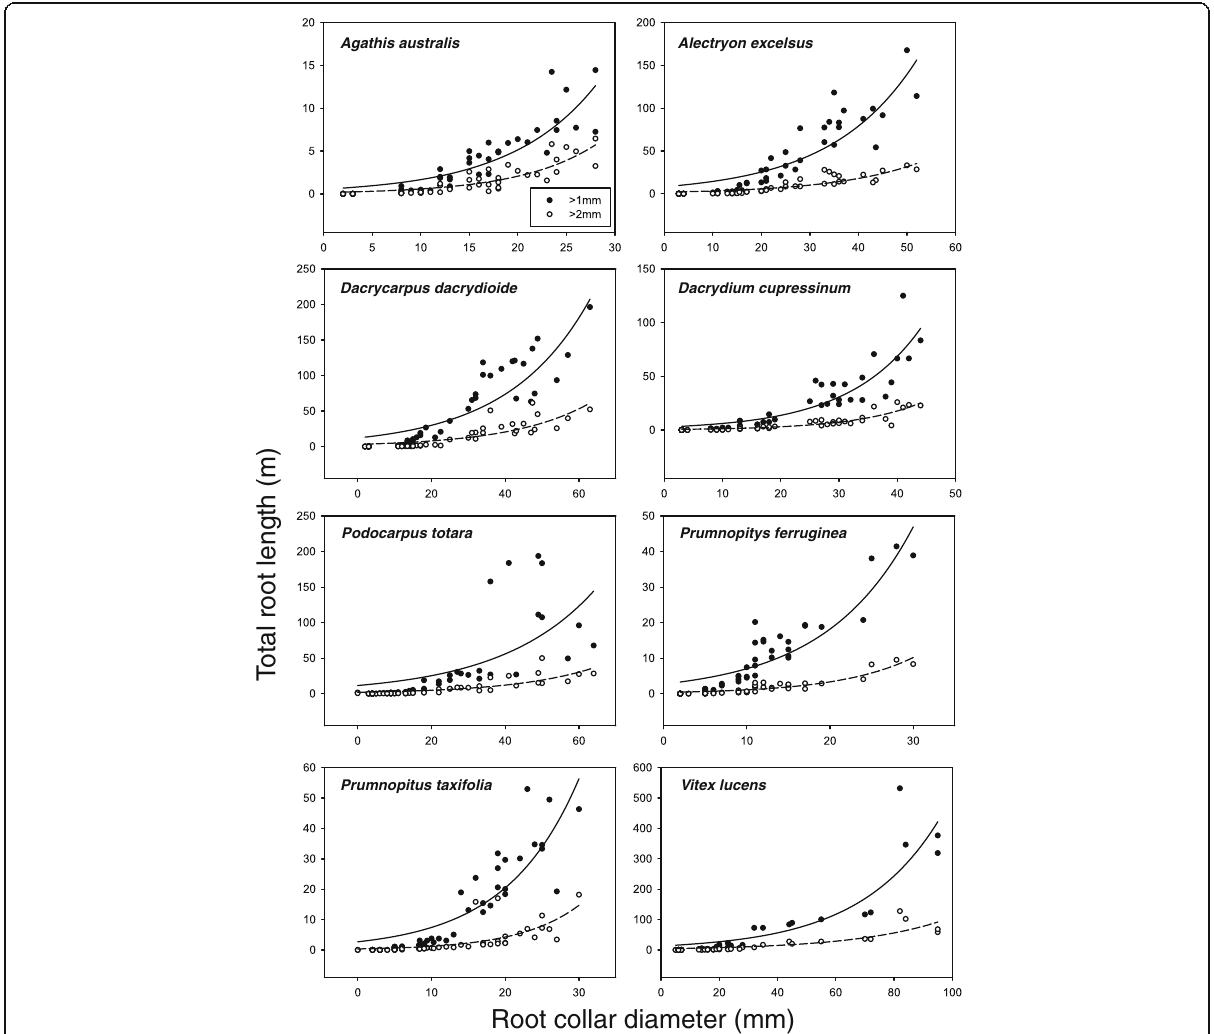
Fig. 10 Exponential growth analysis of RCD and total root length. Note that the scale of the y and x axes differs between